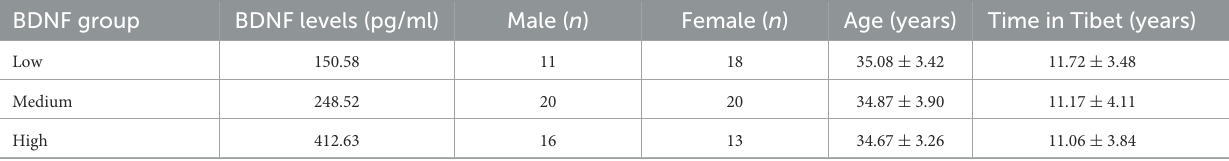
TABLE 1 Basic information of participants in the high and low BDNF